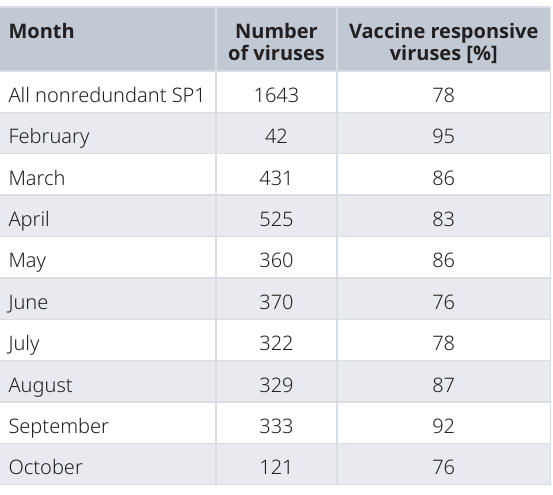
Table 1. Distribution by months of the non-redundant SP1 proteins from SARS-CoV-2 viruses deposited in GISAID from January to October,